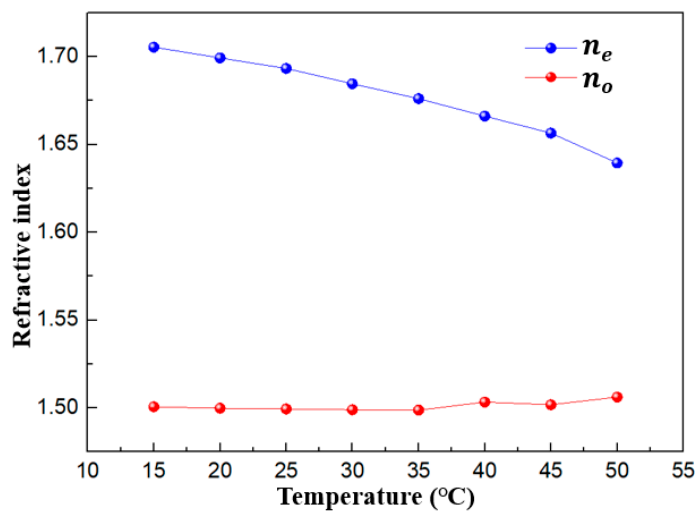
Figure 2. Temperature dependence of the refractive index of the nematic E7 liquid crystal.